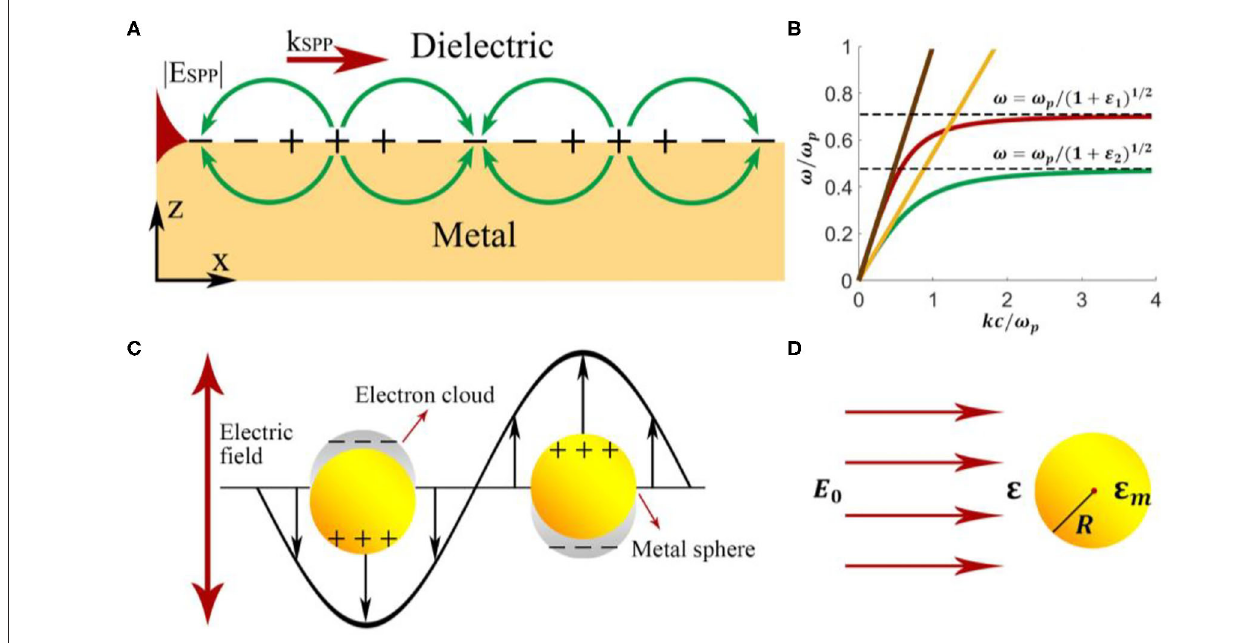
FIGURE 1 | Schematic illustration of (A) surface plasmon polaritons and (B) excitation of SPPs on the metal-vacuum interface. The two curves are the dispersion relation of SPPs on the metal-vacuum interface (red line) and that on the metal-GaAs interface (green line). The dispersion relations of light incident from vacuum and GaAs are plotted as the yellow line and the brown line, respectively. (C) Localized surface plasmon polaritons at the interface between metal nanoparticles and dielectric environment. (D) A metal nanoparticle with a radius R in the electric field E 0